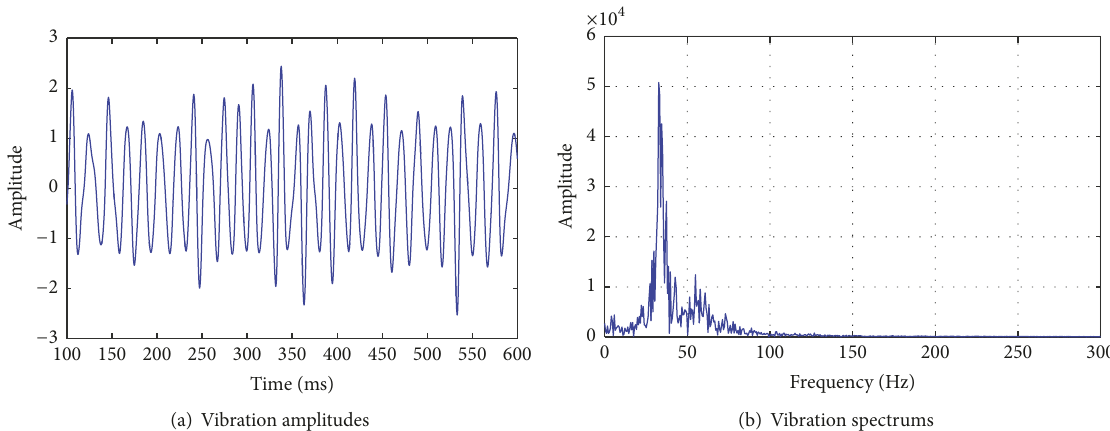
Figure 6: The horizontal direction response of the disk ( 𝜆 = 0.1 , 𝛿 = 0.0001